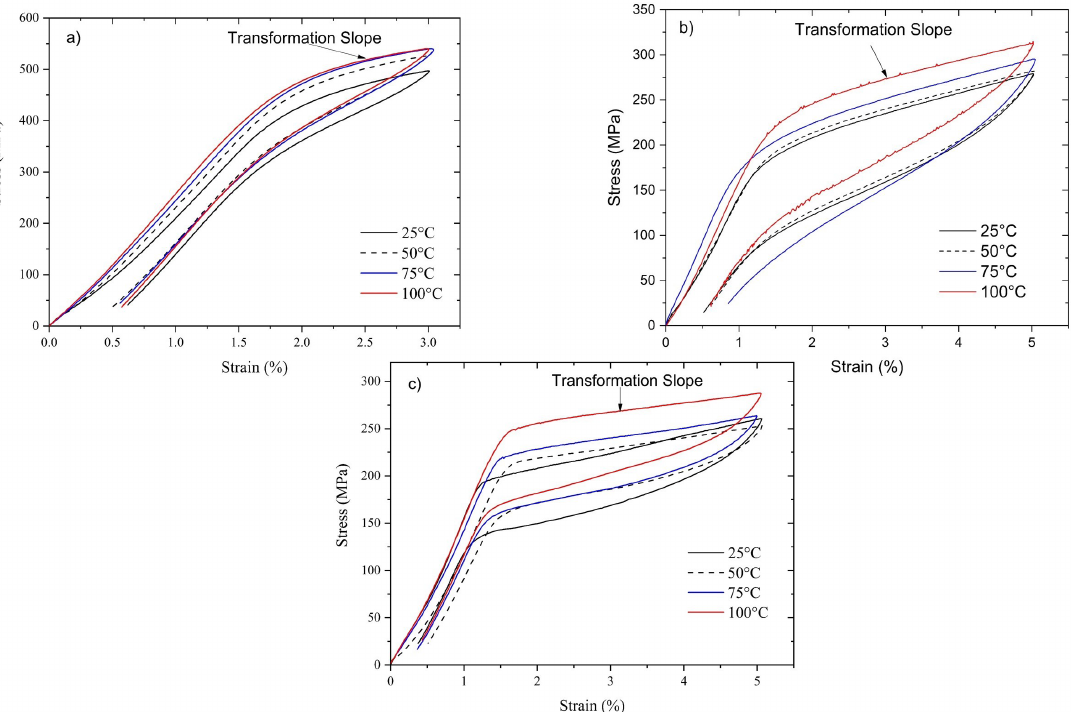
Figure 5 - Superelastic behavior at different Cu-Al-Be-Cr alloy temperatures: (a) 0% HR (a) 100% HR and (b) 30% HR.